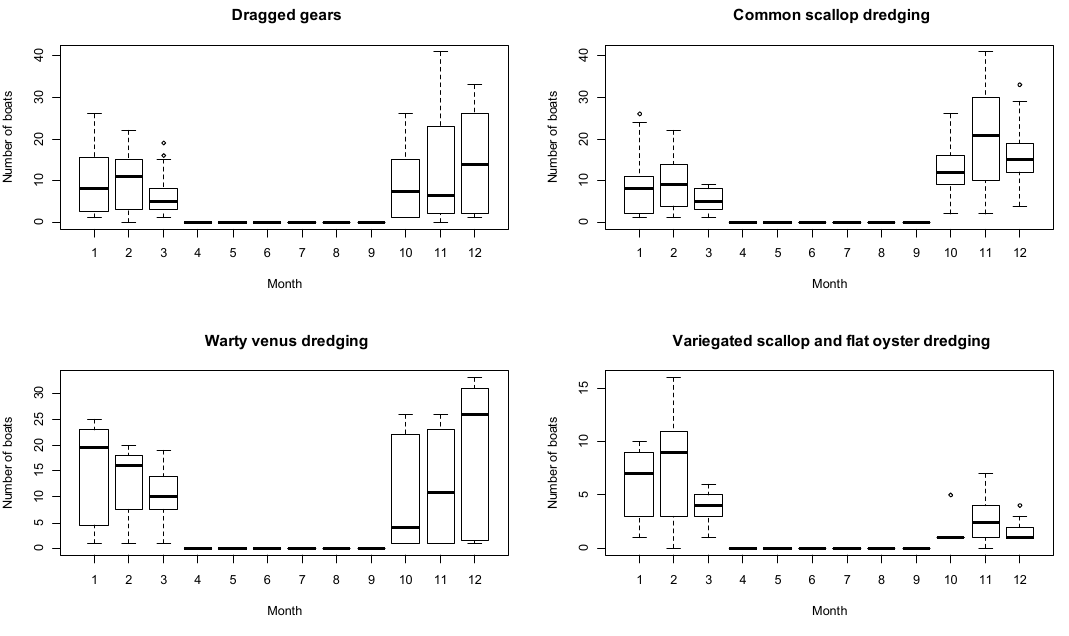
Figure 4. An example of an activity calendar (data aggregated per